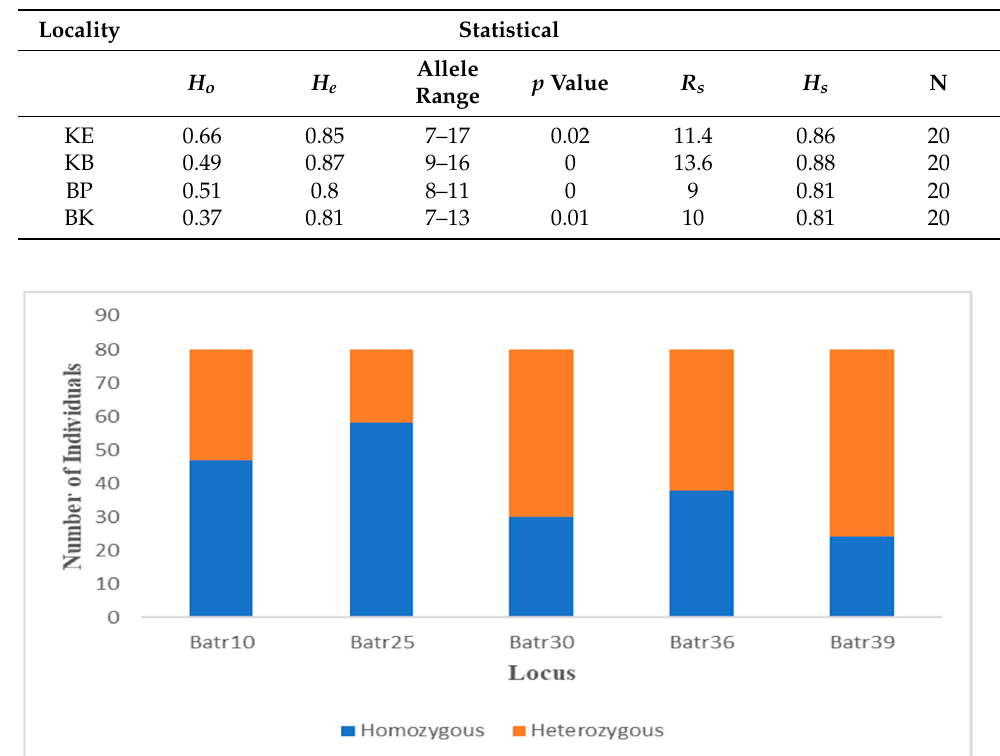
Figure 2. Frequencies of homozygous/heterozygous individual alleles represented for the five loci. Thus, total R s indicated that the examined populations used cross-amplified primers at a greater rate than the B. baska population [22]. The sample size may affect the allelic richness and H s . The authors in [25] established the beneficial impacts of sampling populations of 25–30 individuals. They did, however, emphasise the importance of collecting 5–100 samples per collection in order to avoid uncommon non-informative